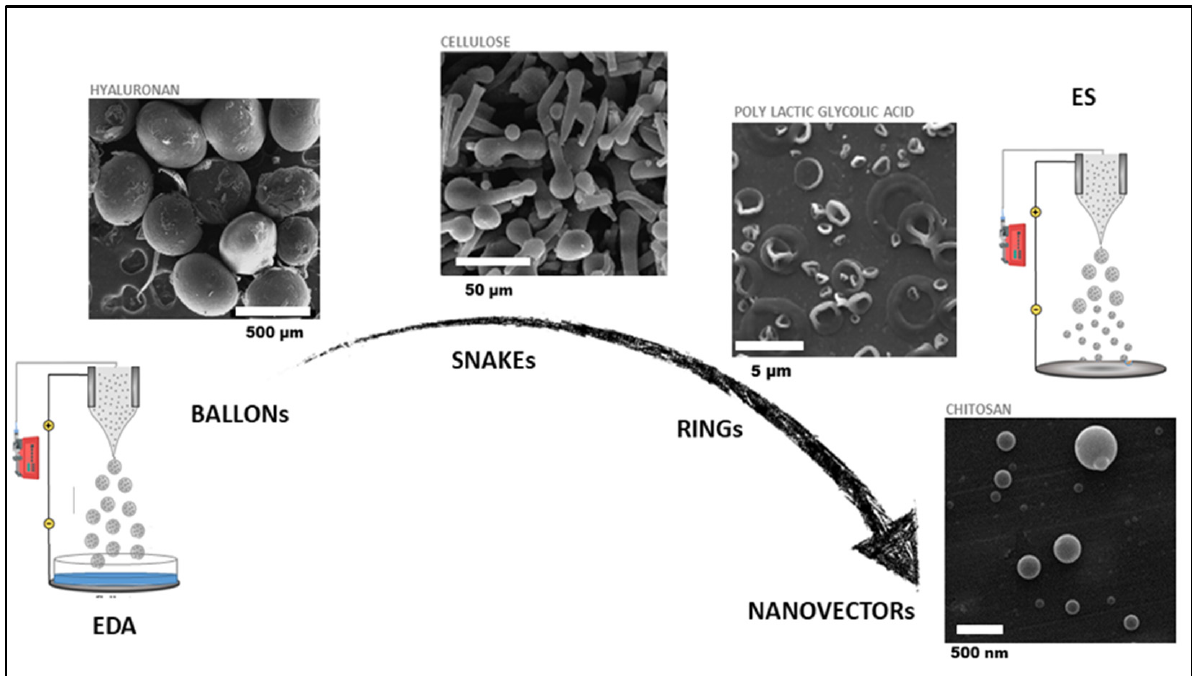
Figure 2. Fabrication of particles based on biomedical/bio-sustainable polymers from macro to nanoscale switching between EDA to ES mode. EDA process is mainly dedicated to the fabrication of balloons made of polysaccharides (i.e., chitosan, alginate) and/or glycosaminoglycans (i.e., hyaluronic Acid [39]) in water solution. EDS process is mainly devoted to the fabrication of nanovectors— i.e., nanoparticles with sub-micrometric or nanometric diameters—using highly volatile solvents (i.e., acetic acid, ethyl acetate). Specific modification of the experimental process setup can impart different sizes and shapes to final particles (i.e., snakes, Rings) [40].